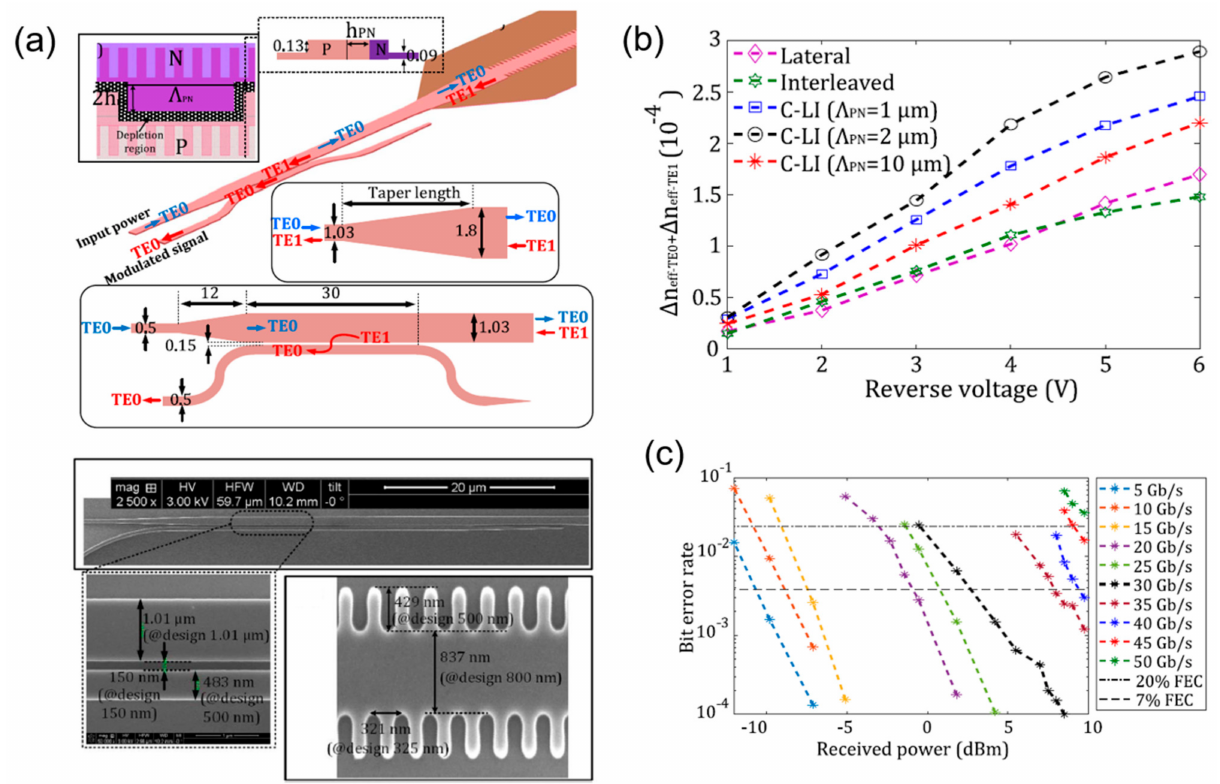
Figure 17. The structure and performance of silicon mode-conversion modulator with asymmetric Bragg grating. ( a ) Schematic and SEM of the modulator structure [76]. ( b ) Phase-shift of the asym- metric Bragg grating modulators with PN junctions of different profiles [76]. ( c ) BER for different modulation speeds [76].